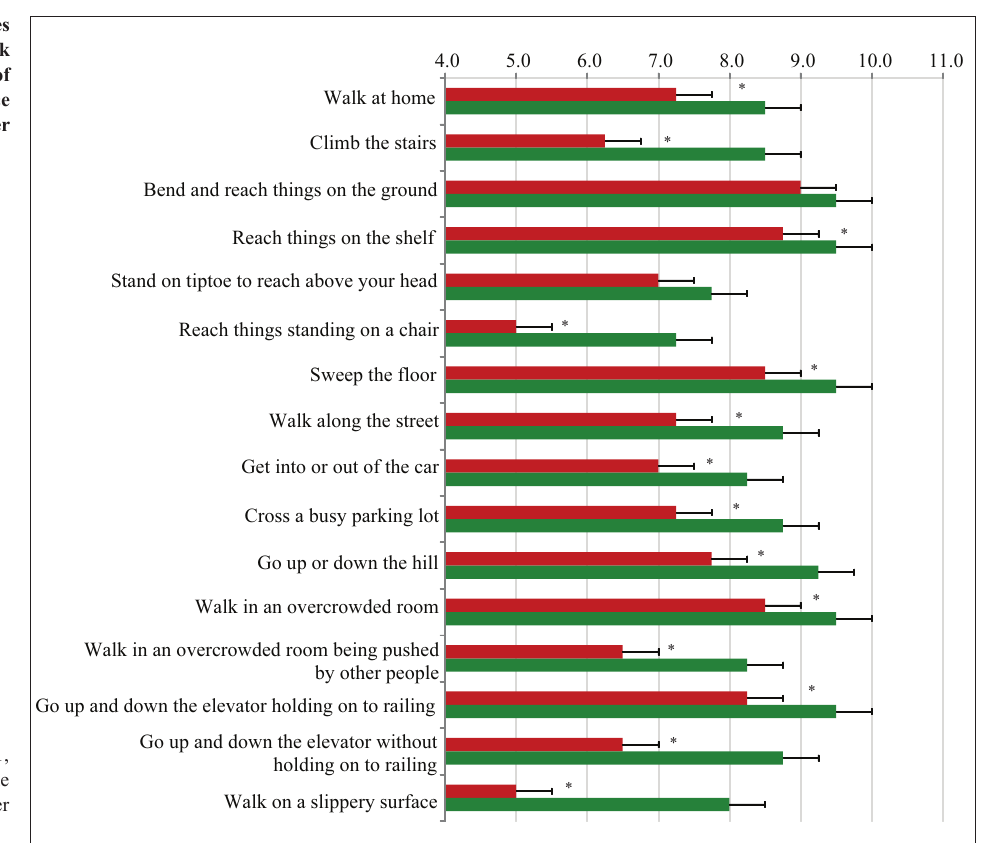
Figure 4. Averages of individual task performance results of Confidence in balance scale before and after physiotherapy